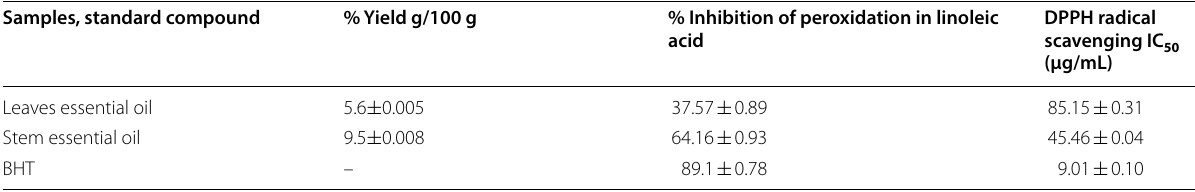
Values are mean SD of three separate experiments (P < 0.05) BHT (butylated hydroxytoluene) ±